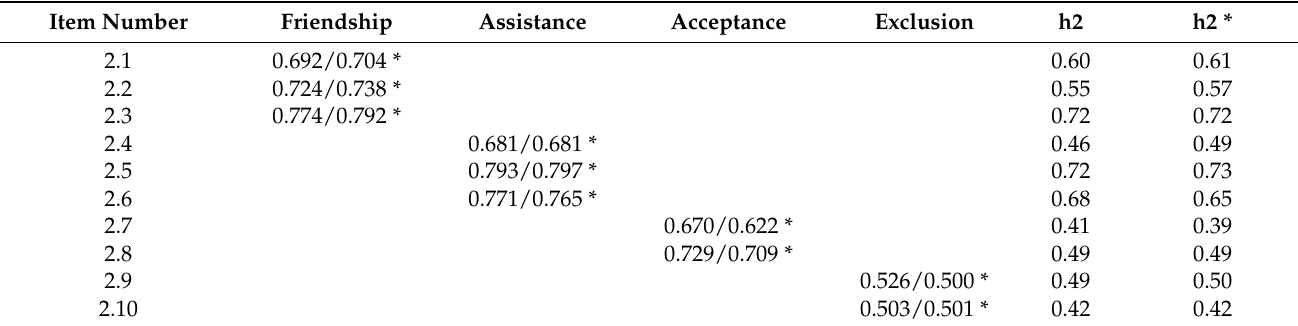
Table 3. Standardized item loadings for Confirmatory Factor Analyses (CFA) and the four factors relating to community inclusion and item communalities for athletes with ID and for both athletes and partners